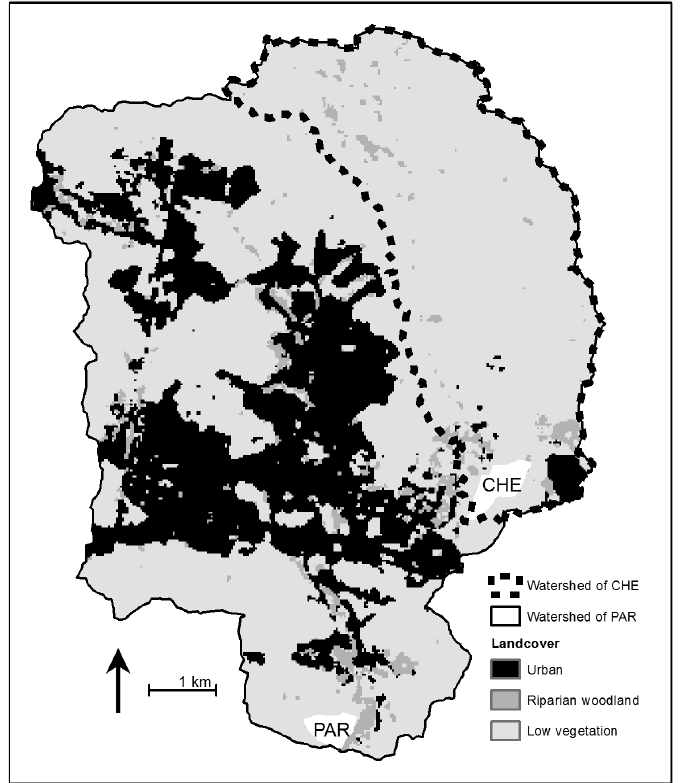
Figure 2. Land cover in the CHE and PAR subwatersheds of the Malibu Creek Watershed. Entire land cover data extent is the watershed of PAR. Area enclosed by dashed line is the watershed of CHE. The watershed of CHE is contained in the watershed of